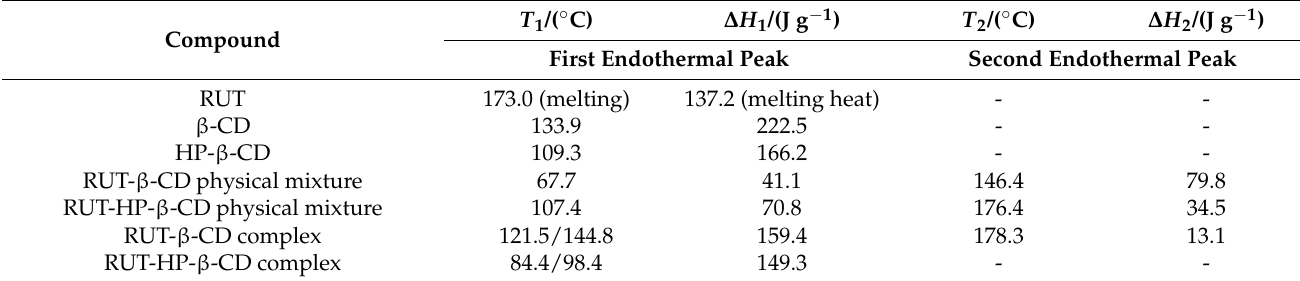
Table 2. The characteristic temperatures ( T) and area of the characteristic peaks ( ∆ H ) obtained from DSC curves. Compound First Endothermal